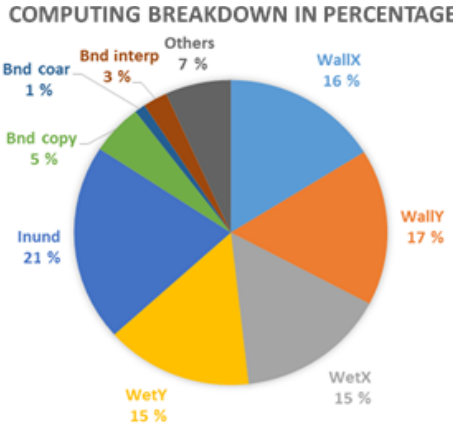
Figure 16. Computing breakdown shown in percentage.